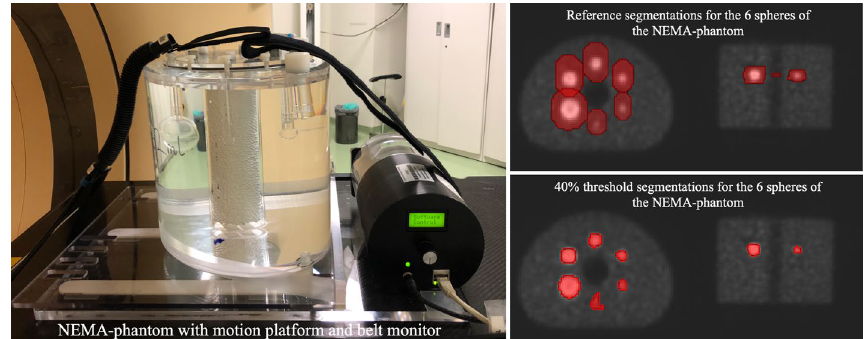
Fig. 2 Setup employed for volume quantification. Axial, coronal an sagittal view of the PET static image of NEMA phantom and examples of the references and the automatic segmentations